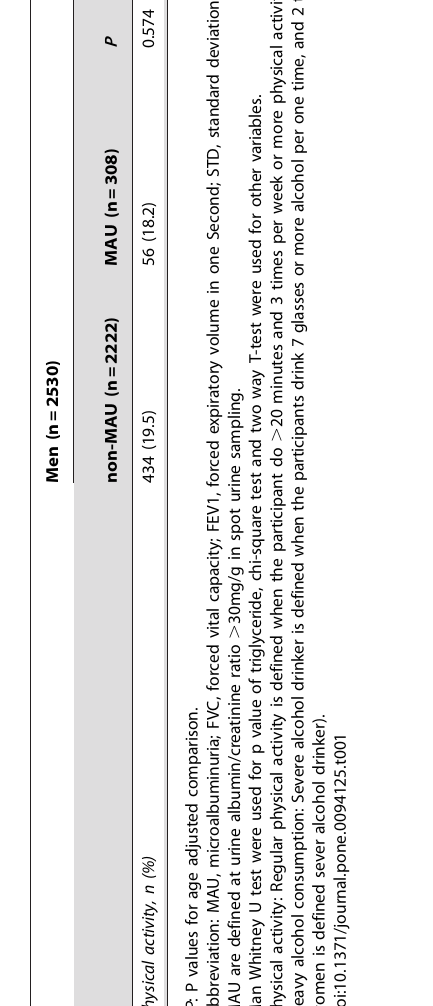
Frequency with percentage, mean with standard deviation (SD), or median with interquartile range was used to interpret the participant characteristics according to non-MAU vs. MAU status as appropriate. Furthermore, age adjusted comparisons were undertaken by using generalized linear model in table 1. Regression coefficients of UACR were calculated with respect to 10% lower percent predicted FVC and FEV 1 values in multiple regression models. Odds ratios (ORs) with 95% confidence intervals (95%CI) were calculated in multiple logistic regression models according to poor lung function pattern (normal vs. restrictive or obstructive pattern).